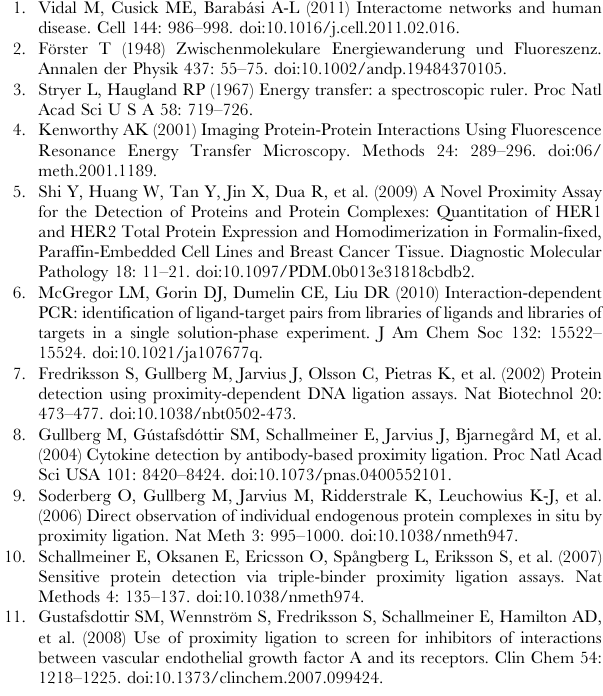
Table S1 Raw data for Figure 3 and Figure S5. Listed are the measured Cy5-intensities and Cy3-intensities for the experi- ments presented in a) Figure 3 and b) Figure S5. The ratios between the Log 2 (Cy5/Cy3) are calculated for individual array features, and an average value is calculated for the three replicate features within a subarray. Table S2 List of oligonucleotides used in the experi- ments. Listed are the sequences of all oligonucleotides used in the experiments together with their modifications in the 3 9 -free and 5 9 -free ends respectively. Table S3 List of antibodies used in the experiments. Listed are the antibodies with their target proteins, catalog number and manufacturer, any modification, type of immunoglobulin (Ig), and concentrations in various assays. (TIF) File S1 Supplementary Results and Materials and